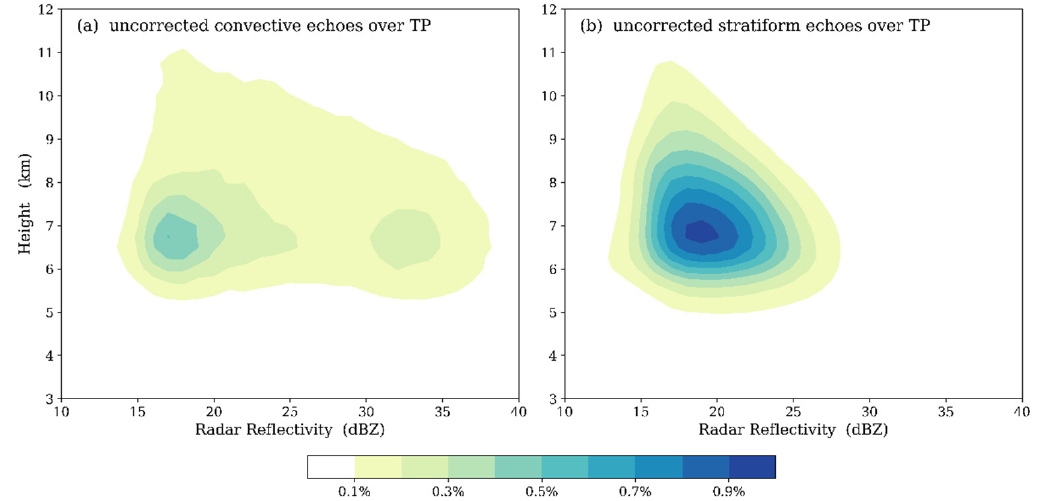
Figure 2. Contoured frequency by altitude diagrams showing the frequency distribution of ( a ) convective and ( b ) stratiform echoes from the GPM datasets over the Tibetan